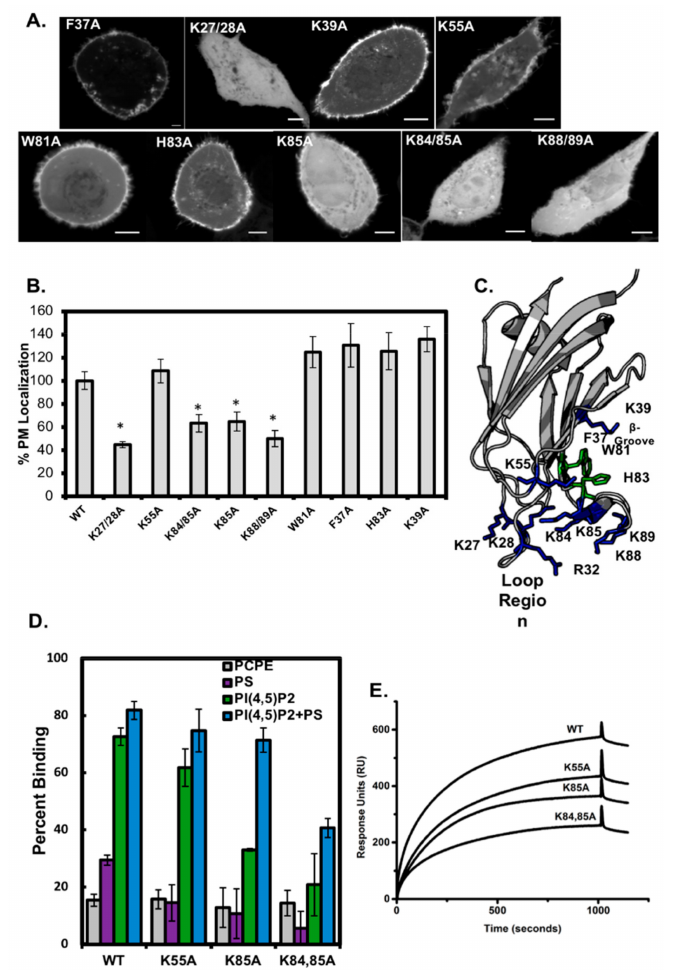
Figure 4. The analysis of Smurf1 C2 lipid-binding mutants demonstrates that the C2 domain loop region is essential for membrane localization and PIP binding. ( A ) The mCherry–Smurf1 C2 domain and the corresponding mutants were introduced into A549 cells to detect changes in plasma membrane localization. ( B ) The %PM localization was determined for all Smurf1 C2 domain mutations shown in A, with the wild-type Smurf1 C2 domain normalized to 100%. A one-way ANOVA was performed (* p < 0.008) to determine statistically significant di ff erences. ( C ) Structure of the Smurf1 C2 domain (PDB ID: 3PYC) with the loop region and β -groove mutation residues highlighted. ( D ) A MLV binding assay was performed (Figure 1) for wild-type, K55A, K85A and K84 / 85A Smurf1 C2 domain using control vesicles (POPC:POPE, 80:20) and those containing PS (POPC:POPE:POPS, 60:20:20), PI(4,5)P 2 (POPC:POPE:PI(4,5)P 2 , 75:20:5) or PS + PI(4,5)P 2 (POPC:POPE:POPS:PI(4,5)P 2 55:20:20:5). The percent binding (centrifugation assay supernatant and pellet analysis) is plotted as shown. ( E ) Representative SPR sensorgrams are shown for wild-type, K55A, K85A and K84 / 85A injected over